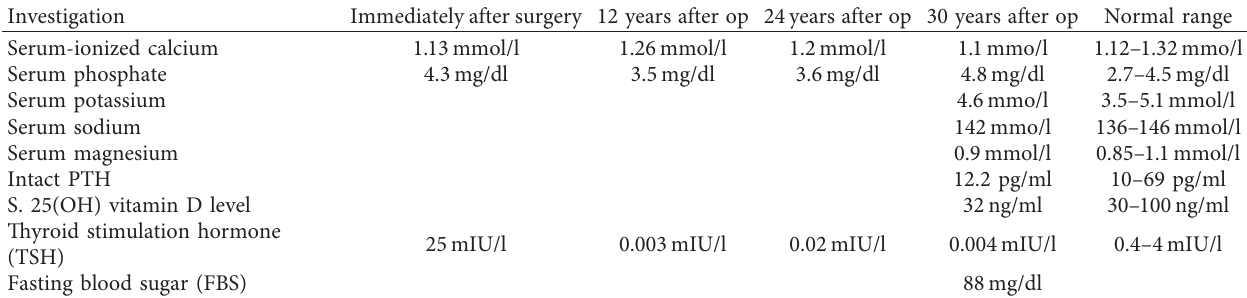
Table 1: Summary of investigations of case